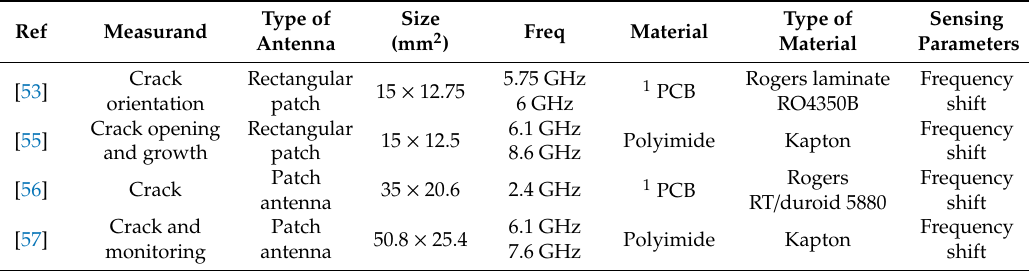
Figure 5. Antenna crack sensor: ( a ) schematic configuration of a patch antenna, ( b ) antenna sensor with crack, and ( c ) e ff ect of cracks on the current model of the sensor [54]. Table 4. Summary of previously reported works on antenna crack